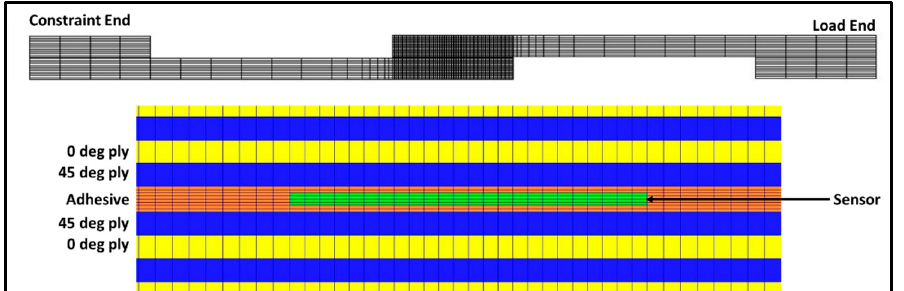
Figure 5. Test coupon static analysis FEM. The sensor was directly connected to the adhesive elements at the nodal locations. The model was run statically with one end constrained and an enforced displacement applied to the free end. The sensor mechanical properties were the same as previously presented. The sensor took up approximately 4% of the shear bond area, so no significant joint degradation was expected due to a simple reduction in the bond area related to the embedded sensor. The simulation results showing the maximum shear stress distribution through the bondline are shown on Figure 6 for the pristine, center-embedded sensor, and load end-embedded sensor.